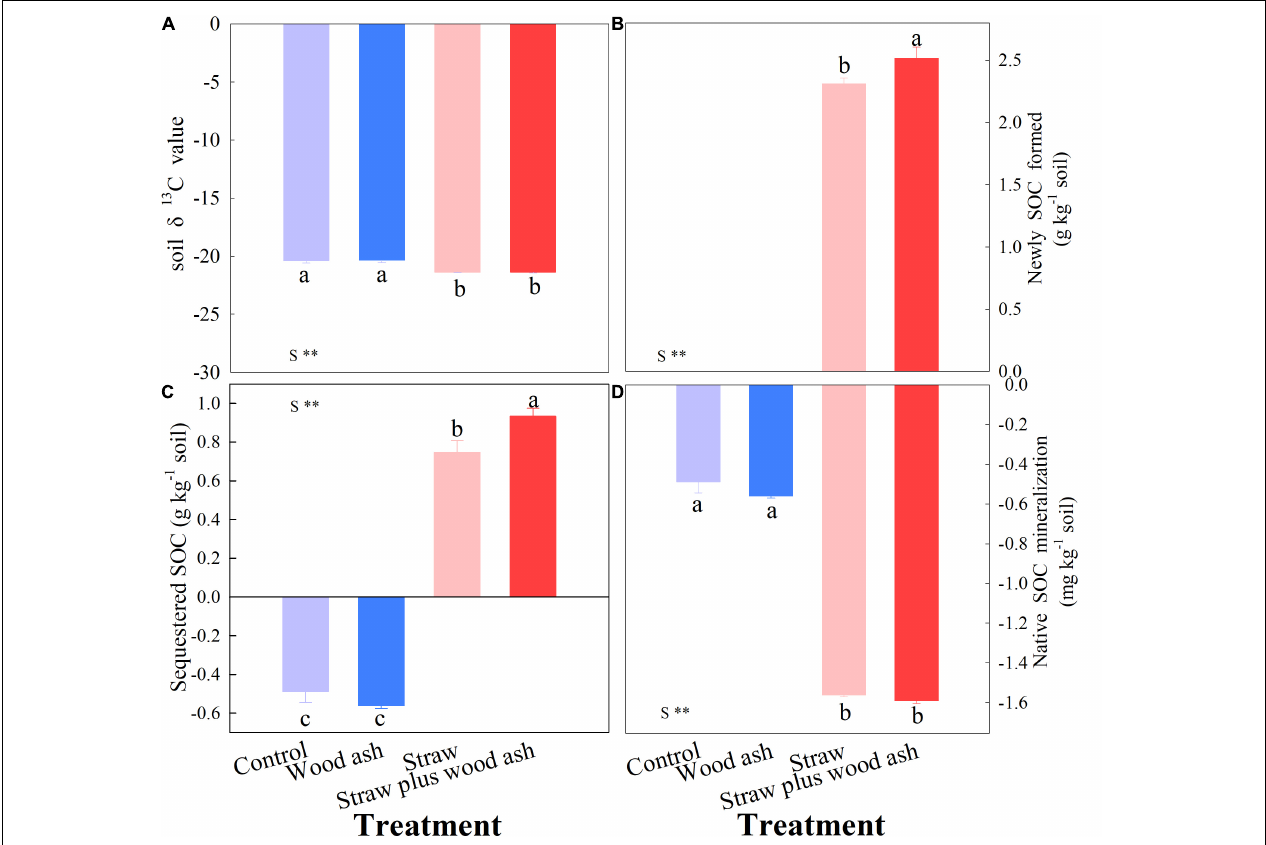
FIGURE 1 | Effects of wood ash and straw treatments (addition or no addition) on the value of soil δ 13 C (A) , on the net change in soil organic carbon (SOC) sequestration (B) , on newly SOC formed (C) and native SOC mineralization (D) at the end of incubation. Data (means ± SE, n = 3) followed by different letters indicate significant differences among the treatments at p < 0.05. See formulas 2, 3, and 4 for the calculation of native SOC minimization. **Indicated that there was significant difference between straw and other